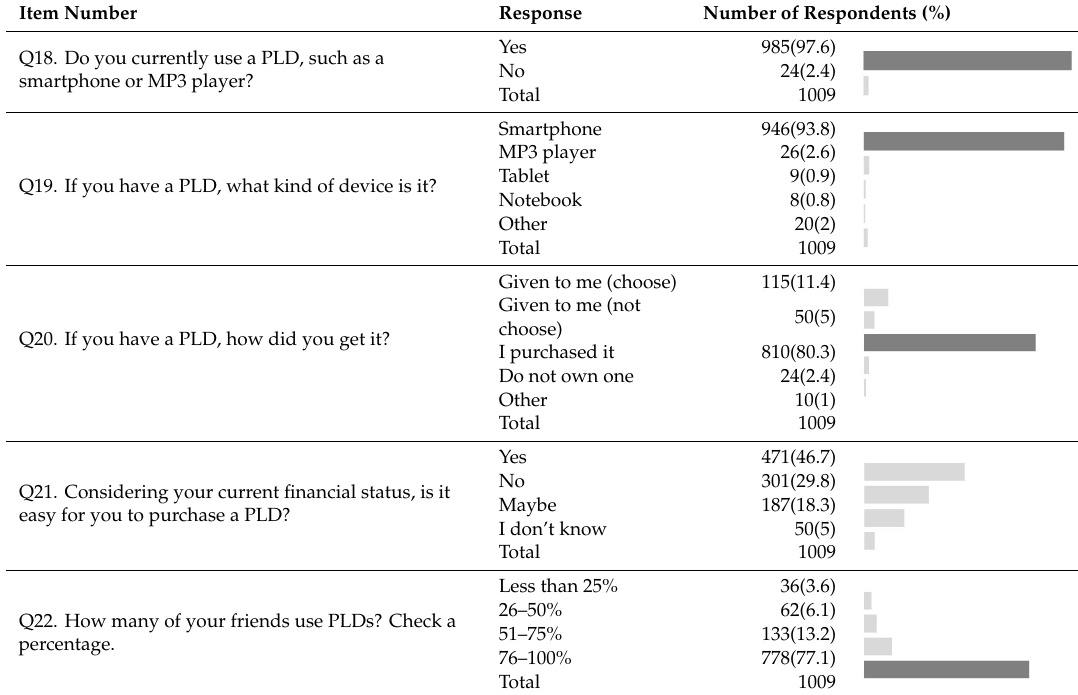
Table A3. Selection and PLD